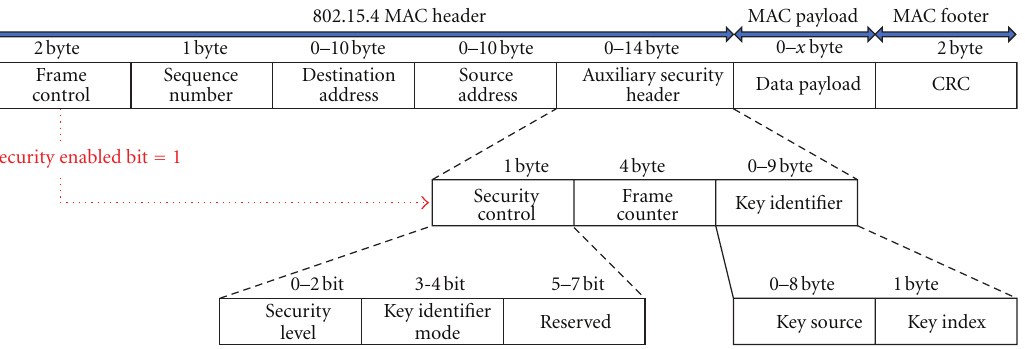
Figure 16: IEEE 802.15.4 MAC frame and security issues.